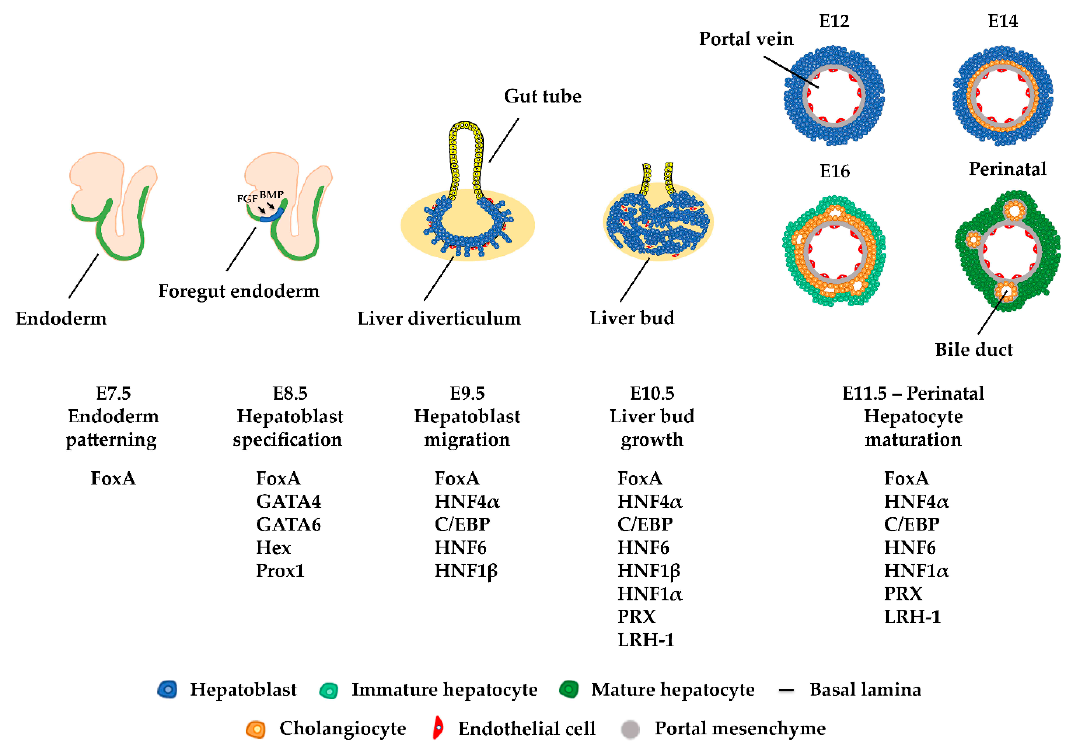
Figure 1. Liver development. Liver organogenesis begins in the definitive endoderm at E8.5. BMP signals from the septum transversum and FGF signals from the adjacent heart induce cells in the ventral foregut endoderm to differentiate towards hepatoblasts. After hepatoblast specification, the hepatic epithelium is re-organized and forms the liver diverticulum. By E9.5, hepatoblasts are able to migrate into the septum transversum mesenchyme and produce the liver bud. Between E9.5 to E15, hepatoblasts expand and the liver bud grows. At these stages, the formation of canalicular structures and the appearance of endothelial sinusoid cells become detectable. Around E13, hepatoblasts begin their differentiation into hepatocytes or cholangiocytes, followed by the formation of the zonal structures as specified by the central vein and portal triad regions.